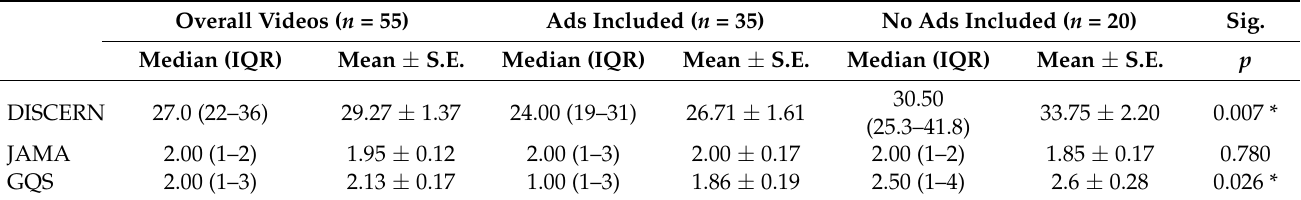
Table 2. Descriptive statistics of scoring systems regarding